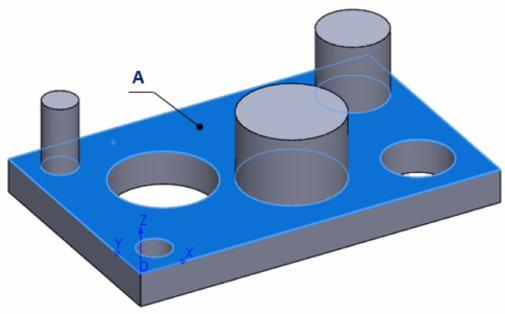
Figure 12. Definition of the measured flat